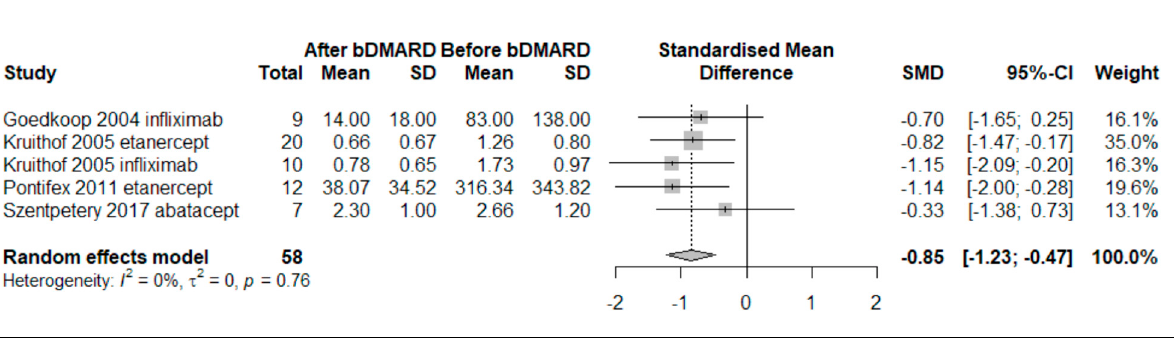
Figure 2. Forest plot of standardized mean difference of CD3+ lymphocytes in synovial tissue of PsA patients treated with bDMARDs. Negative effect means reduction in CD3+ lymphocyte level. Abbreviations: bDMARD: biological disease-modifying anti-rheumatic drug, SD: standard deviation, SMD: standardized mean difference; 95% CI: 95% confidence interval.